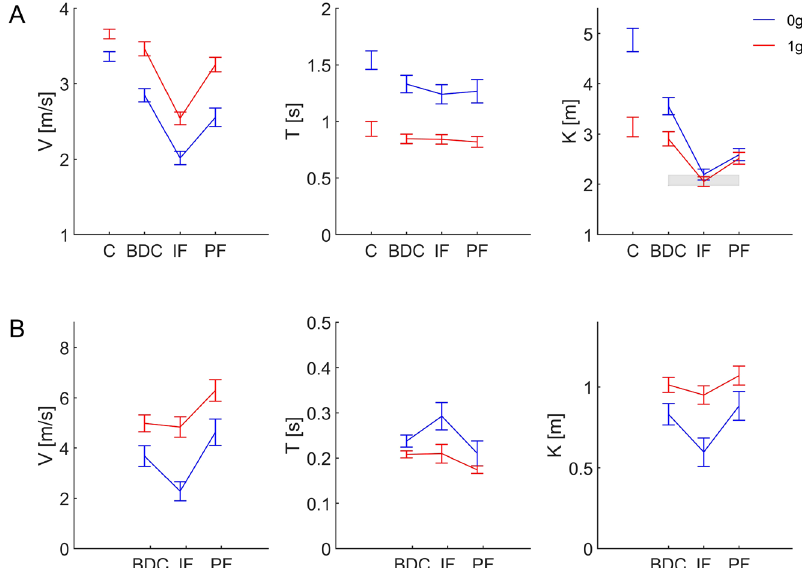
Fig. 4 Global performance parameters. Mean values and 95% con fi dence limits of V , T , and K over all trials, imaginary 0 g (blue) and 1 g (red), pre- fl ight, in- fl ight, and post- fl ight. A Main experiment: seven astronauts and eight controls (labeled C). The gray area denotes the 95% con fi dence interval for the mean estimated hand-to-ceiling distance. B Frontal throws (participant S12).